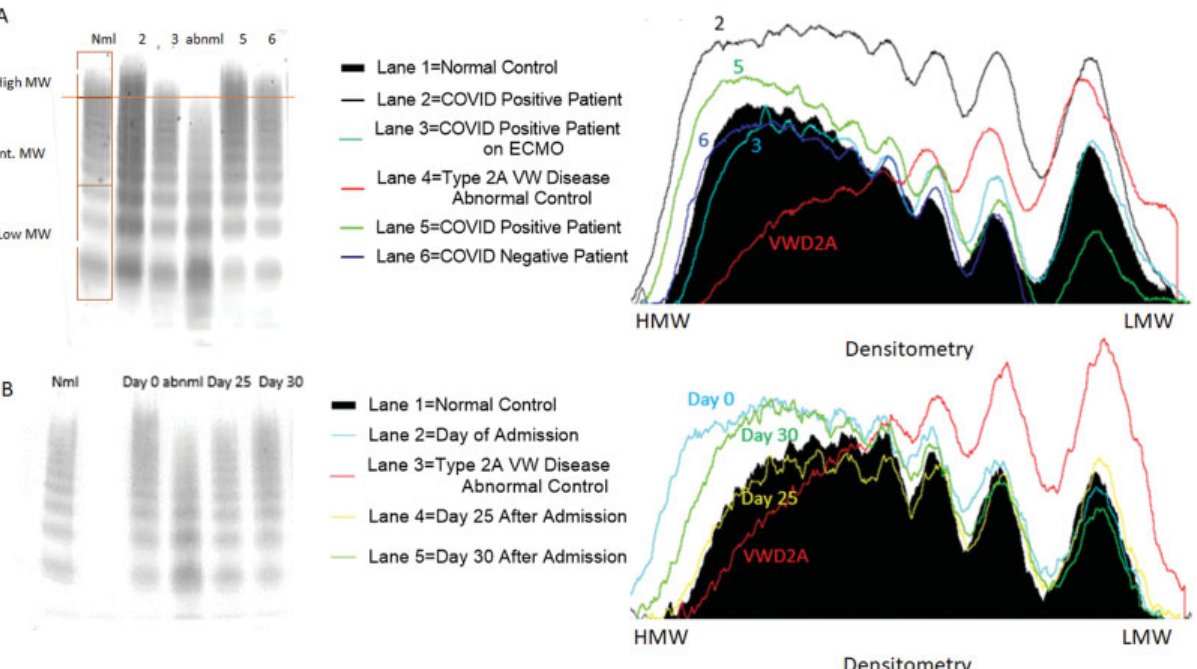
Fig.1 Cross sectional and longitudinal analysis of VWF multimers. For each multimer western blot, patient plasma was run on each lane, and the loading of all samples was normalized to measured VWFantigen levels. For each western blot, bands 1 – 3 were considered low molecular weight multimers, the bands between band 4 and the last band of the abnormal control were considered intermediate molecular weight multimers, and the bands above the last band of the abnormal control were considered HMW multimers. ( A ) The Western Blot to the left shows a pattern of VWF multimer cleavage in fi ve patients. Lane 1 is the negative control, which was derived from normal pooled plasma, and lane 4 is the abnormal control, which was derived from the plasma of a patient with Type II von Willebrand disease. The abnormal control is missing HMW multimers. Lanes 2, 3, and 5 are from COVID-19 positive patients. The patient in lane 6 is from a COVID-19 negative patient with a normal multimer pattern. The COVID-19 positive patients have increased high molecular weight multimers, except for the patient in lane 3 who was on extracorporeal membrane oxygenation at the time of sample collection. The image to the right of the blot is the densitometry of the lanes represented in the western blot. The black fi lled in area represents the density of the normal control, and the red line indicates the abnormal control. The other lines indicate the densitometry of the multimers of the patients. ( B ) Longitudinal trends of coagulation parameters of a discharged alive COVID-19 patient. Western blot on the left shows the change in HMW multimer patterns throughout this patient ’ s hospital stay. Lane 1 is the negative control and Lane 3 is the abnormal control. Multimer pattern between lane 1 and 2 was blocked as it was derived from an unrelated COVID-19 patient. Lane 2 corresponds to the day of admission, Lane 4 corresponds to day 25 after admission, and Lane 5 corresponds to day 30 after admission. The image to the right of the blot is the densitometry of the lanes represented in the western blot. The black fi lled in area represents the density of the normal control, and the red line indicates the abnormal control. The other lines indicate the densitometry of the multimers at various timepoints of the patient. Note that by day 25, HMW multimers decreased to normal size. COVID-19, coronavirus disease 2019; HMW, high molecular